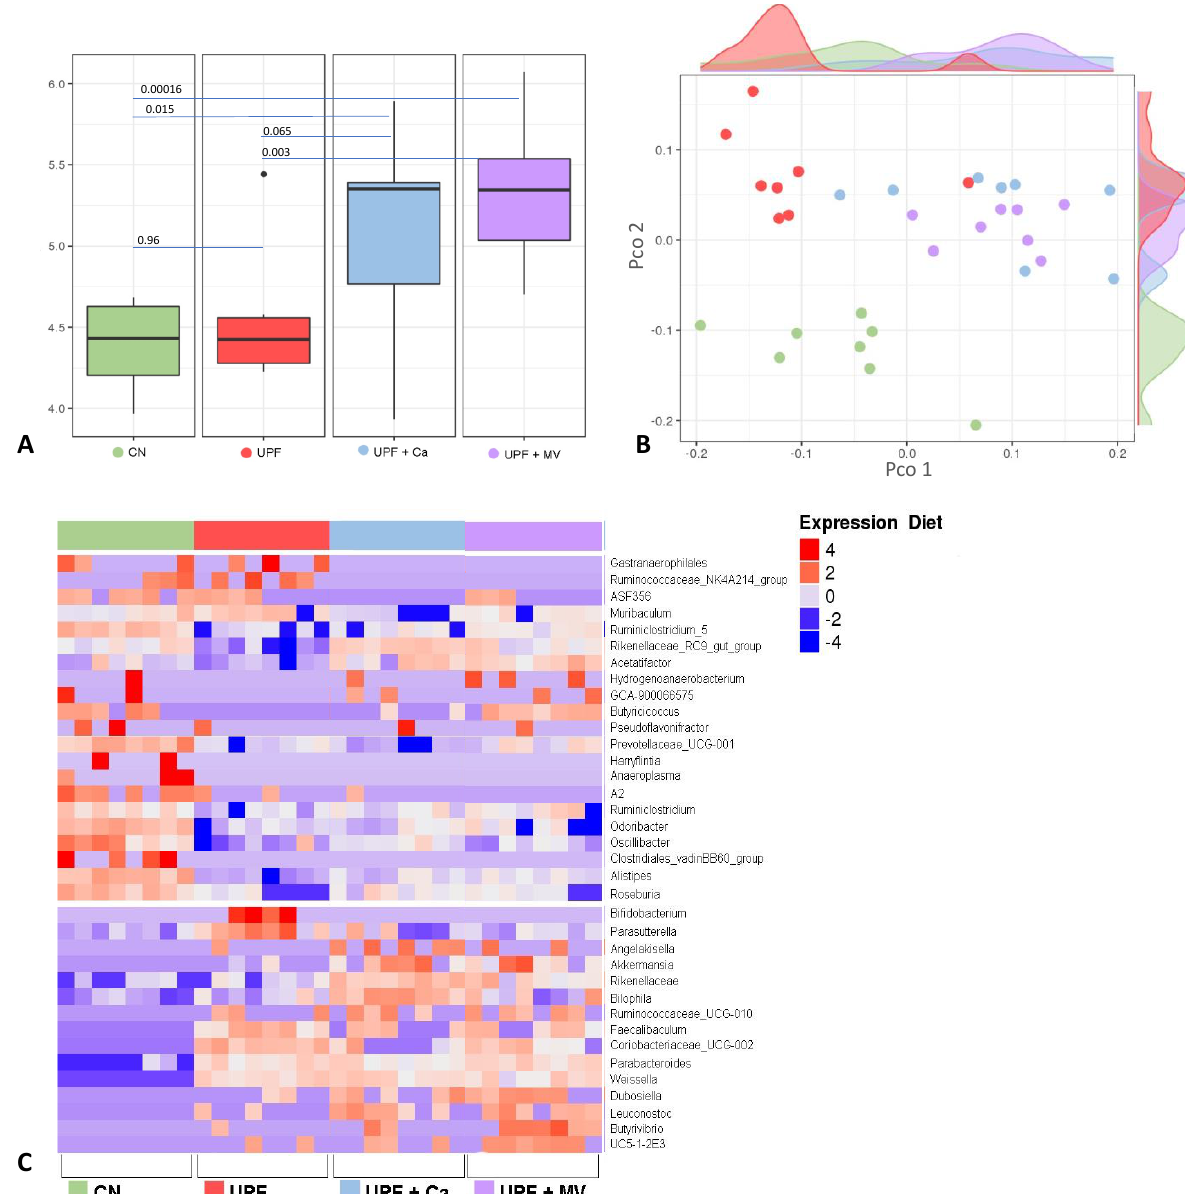
Figure 6. UPF effect on microbiome changes of the gut of mice at 9 weeks of age. ( A ) UPF diet effect on the bacterial diversity within samples by using Shannon index. p -value was calculated using Pairwise comparisons wilcox.test. ( B ) The UPF diet effect on the distance between samples based on Bray – Curtis distances matrix. ( C ) Changes in the bacterial profile, results were analyzed using Deseq2 and assessed using heatmap. CN – control, UPF – ultra processed food, UPF+Ca - ultra processed food supplemented with calcium, UPF+MV - ultra processed food supplemented with multivitamin and mineral complex.